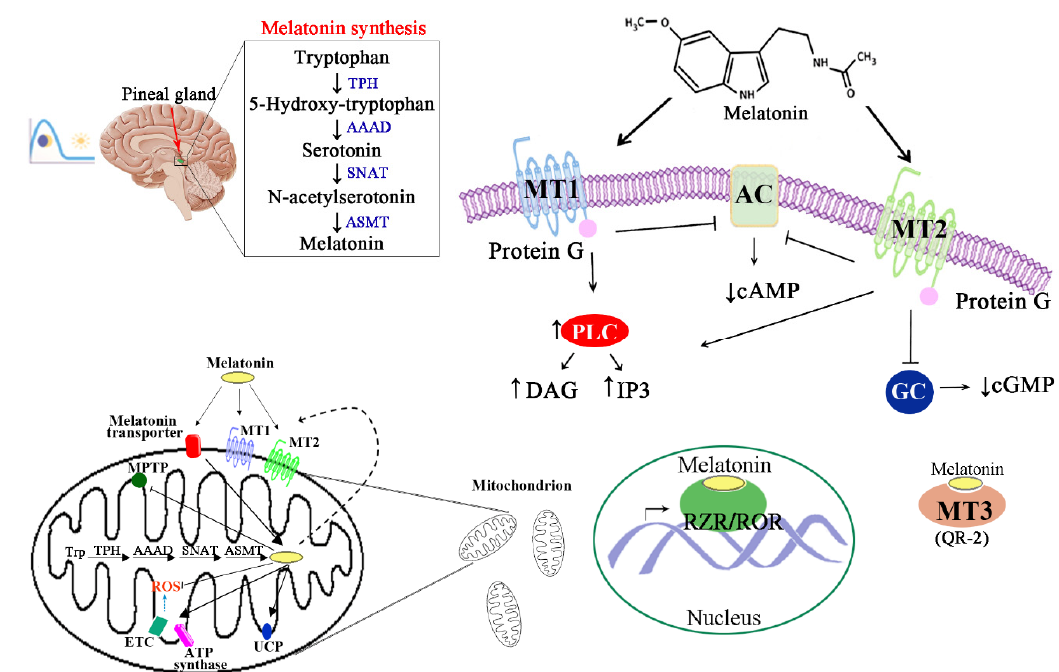
Figure 1. Melatonin biosynthesis and intracellular signal-transduction pathways activated by stimulation of melatonin specific receptors. The picture shows: ( figure top left ) the intracerebral site of melatonin biosynthesis, that is the pineal gland, the melatonin biosynthetic pathway, and the influence of light and photoperiod change on melatonin biosynthesis; ( figure bottom left ) mitochondrial melatonin biosynthesis and local action: melatonin is synthesized within mitochondrial matrix, but it can also enter the mitochondria through a specific transporter; melatonin activates specific MT1 and MT2 receptors on mitochondrial outer membrane, also in an autocrine way, inhibits MPTP and ROS production, and stimulates ETC and UCP; ( figure right ) melatonin interaction with its specific MT1 and MT2 receptors and RZR/ROR orphan nuclear receptors, and activation of different metabolic pathways. AAAD, aromatic L-amino acid decarboxylase; AC, adenylate cyclase; AFMK, N1-acetyl-N2-formyl-S-methoxykynuramine (melatonin metabolite); ASMT, N -acetylserotonin O -methyltransferase; cAMP, cyclic adenosine monophosphate; cGMP, cyclic guanosine monophosphate; DAG, diacylglycerol; ETC, electron transfer chain; GC, guanylate cyclase; IP3, inositol triphosphate; MPTP, mitochondrial permeability transition pore; MT1-MT3, melatonin specific receptor 1, 2, 3; PLC, phospholipase C; QR-2, quinone reductase 2; ROS, reactive oxygen species; RZR/ROR, retinoid Z receptor/retinoid acid receptor-related orphan receptor; SNAT, serotonin N -acetyltransferase; TPH, tryptophan hydroxylase; UCP, uncoupling protein.